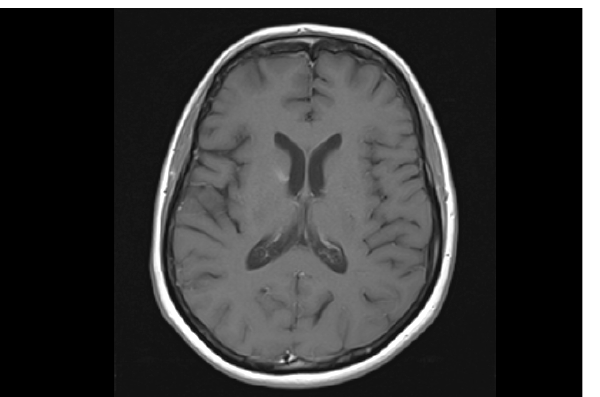
Fig. 1b. Diffusion-weighted MRI showing local hyperintensity.